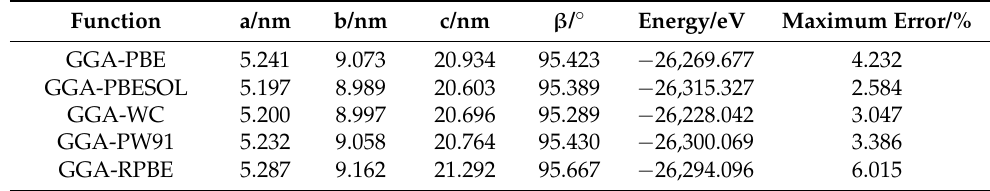
Table 1. Lattice parameters and total energy of muscovite optimized by different functions.